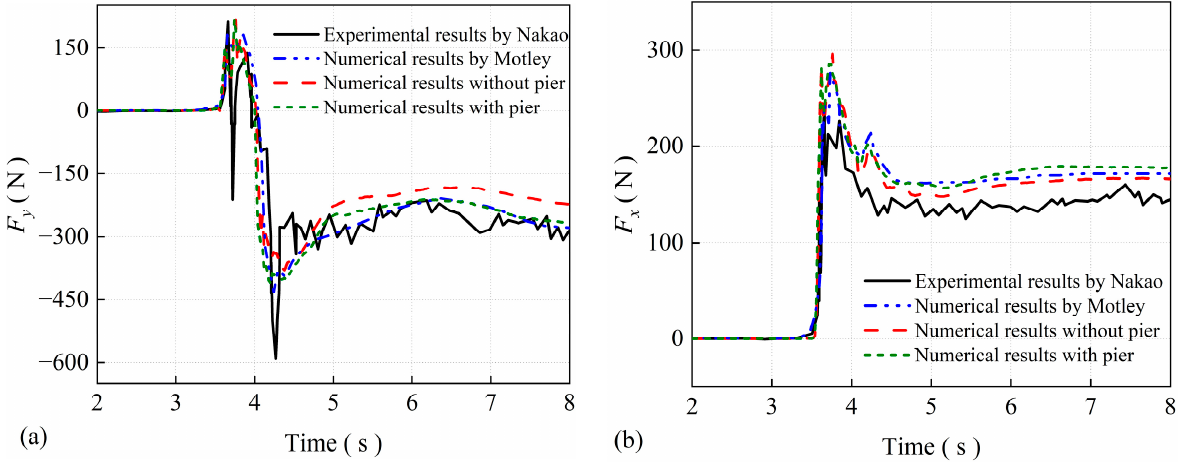
Figure 8. Comparison of the ( a ) horizontal force and ( b ) vertical force on the bridge deck between the presented numerical model and published works.